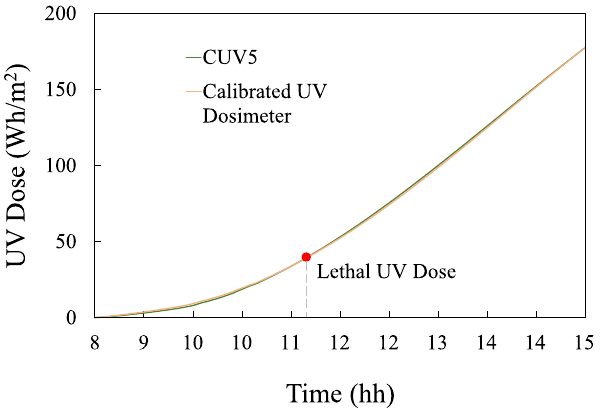
Figure 14. UV dose (Wh/m 2 ) measured on 30 August 2021: proposed device (orange) vs. CUV5 radiometer